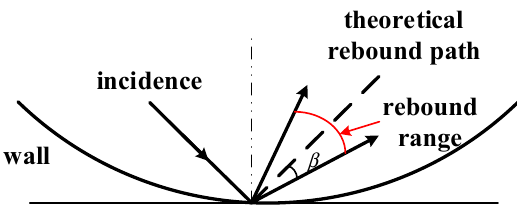
Figure 3. Schematic diagram of collision random angle.